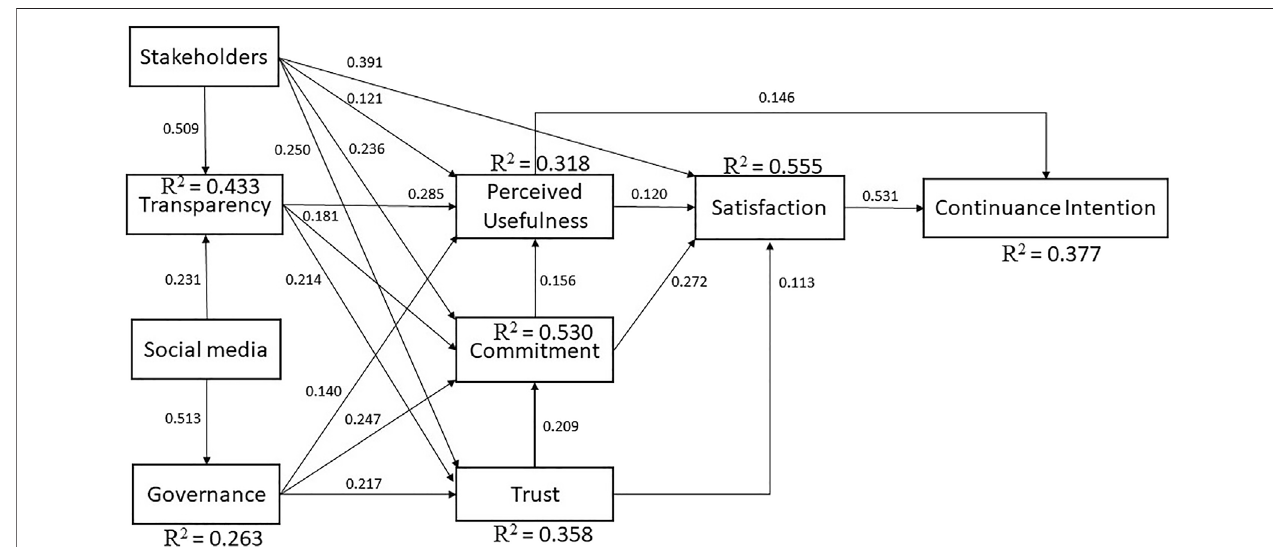
FIGURE 2 | PLS algorithm